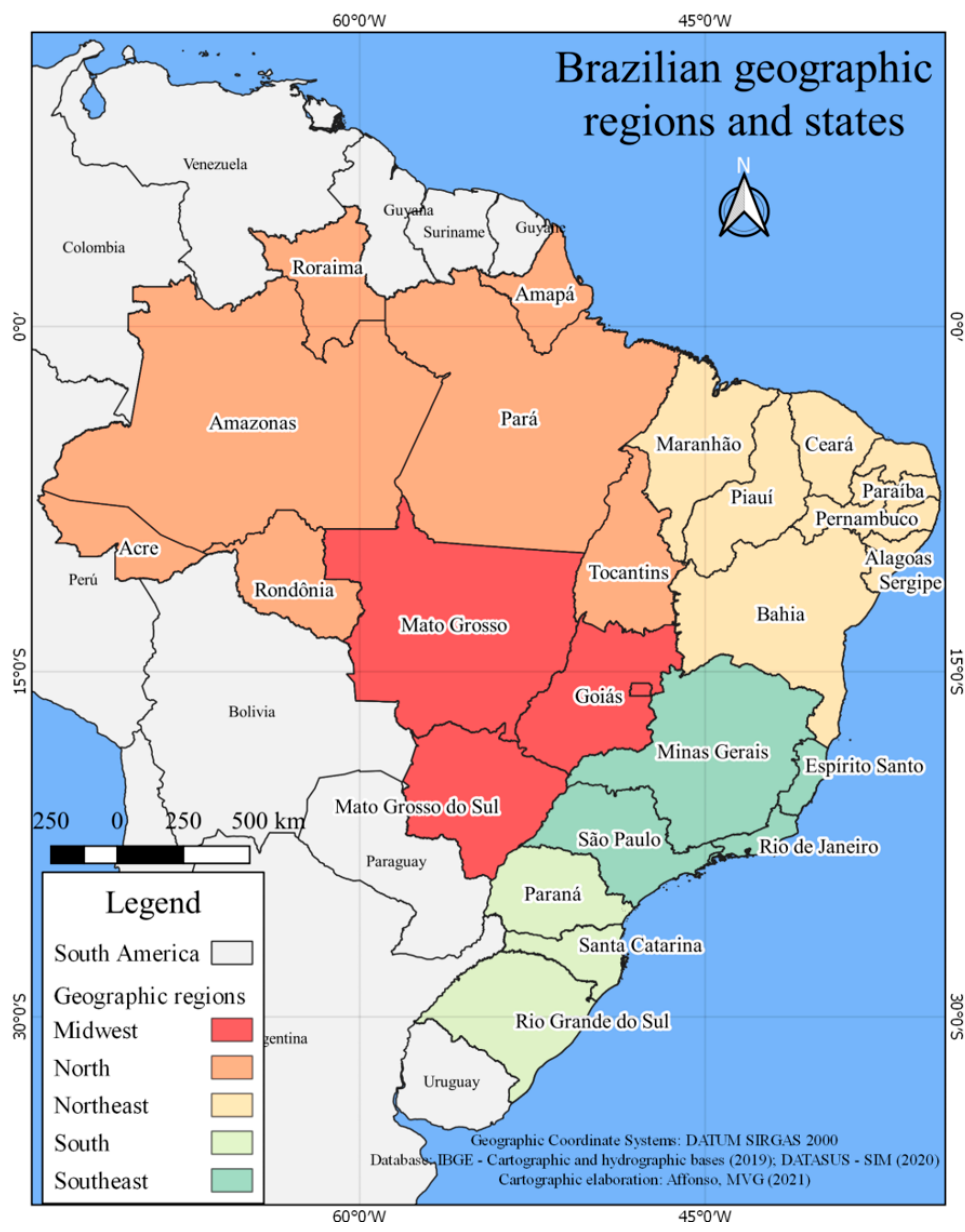
Figure 1. Brazilian geographic region and